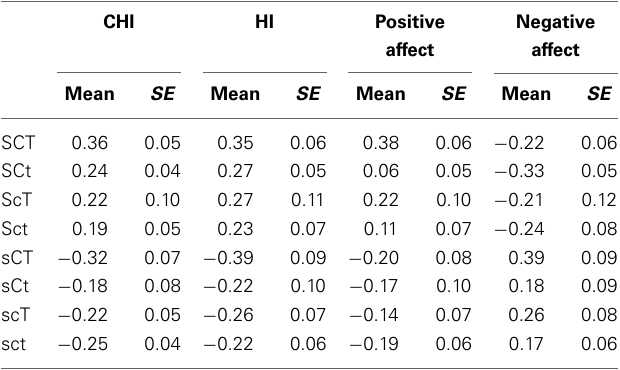
Table 6 | Descriptive statistics for standardized Composite Health Index (CHI), Happiness Index (HI) and positive and negative affects by character